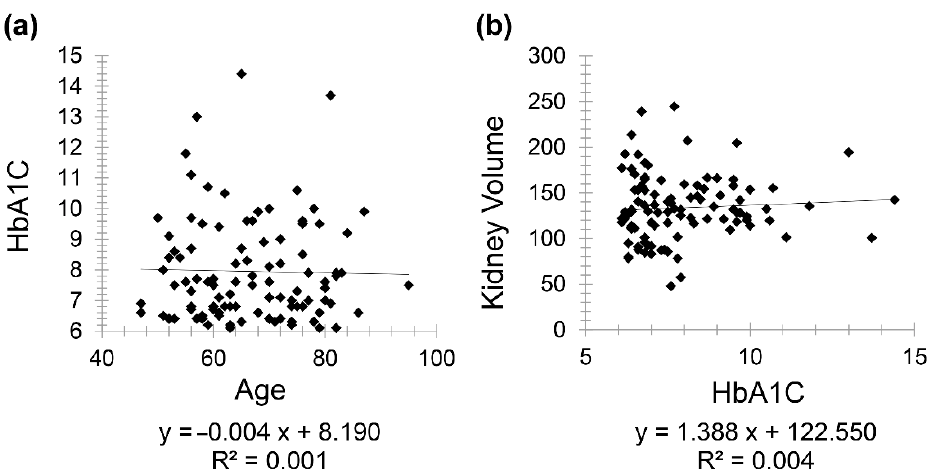
Figure 3. Scatter plot graphs showing ( a ) very weak negative correlation between HbA1C and age ( r = − 0.031) and ( b ) weak positive correlation between kidney volume and HbA1C ( r = 0.063) in diabetic patients.